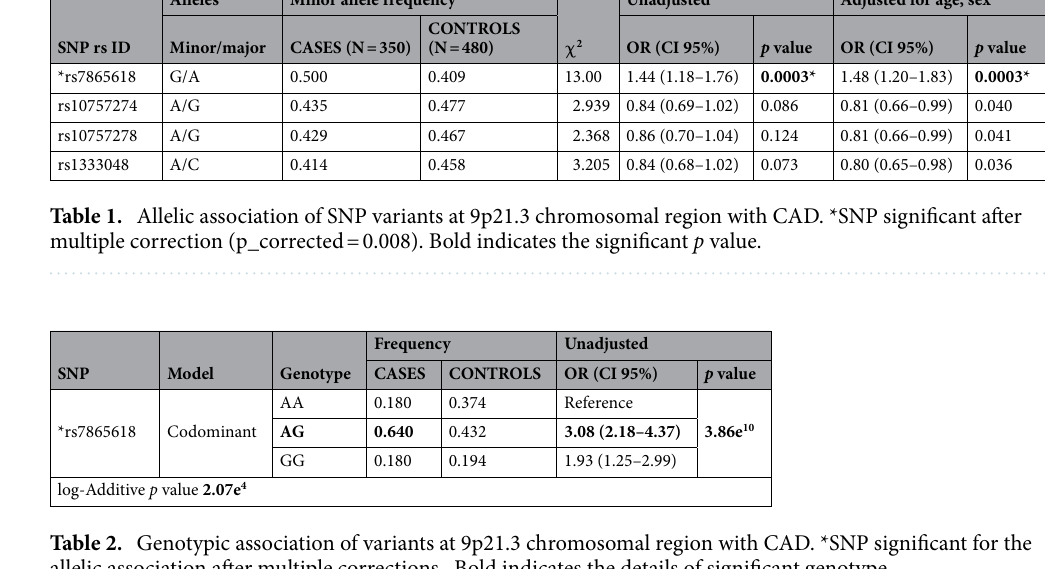
Table 2. Genotypic association of variants at 9p21.3 chromosomal region with CAD. *SNP significant for the allelic association after multiple corrections. Bold indicates the details of significant